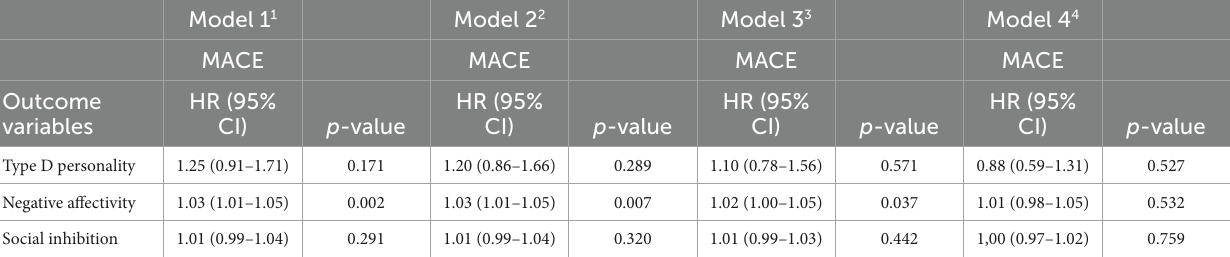
TABLE 2 Hazard ratio [HR] for major adverse cardiovascular events (MACE) in patients with coronary artery disease (CAD).